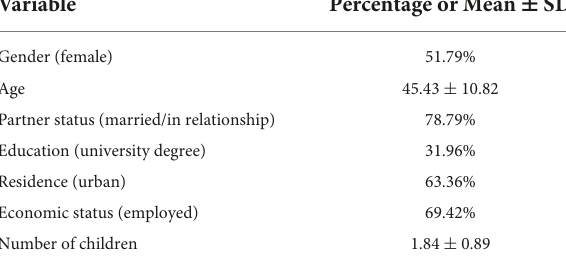
TABLE 1 Demographic characteristics of the